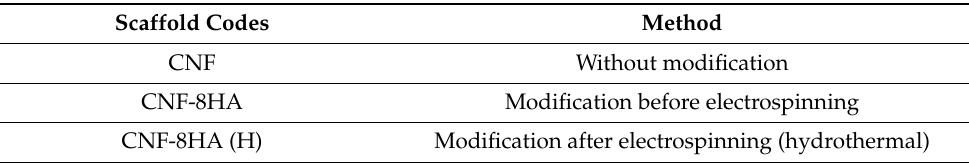
Table 1. Scaffold codes with the certain method of